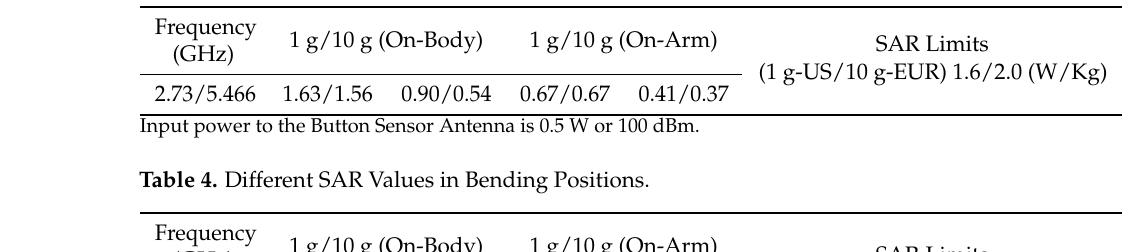
Table 3. Different SAR Values in Flat Positions.